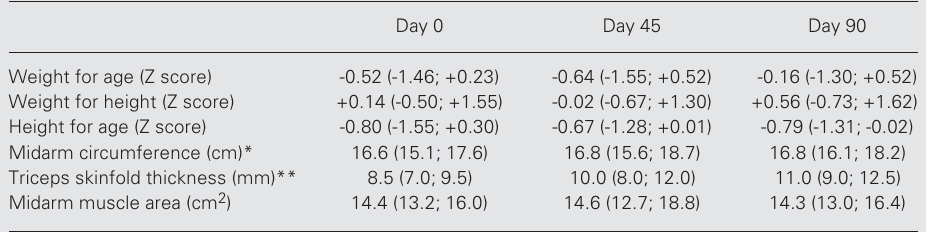
Table 3. Anthropometric data during the treatment of 16 patients with chronic constipation.